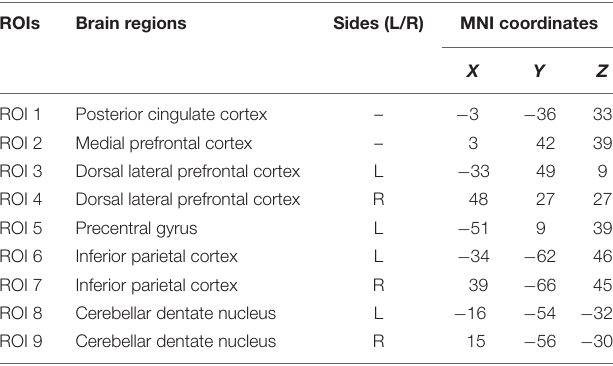
TABLE 1 | Brain regions for granger causality analysis across all